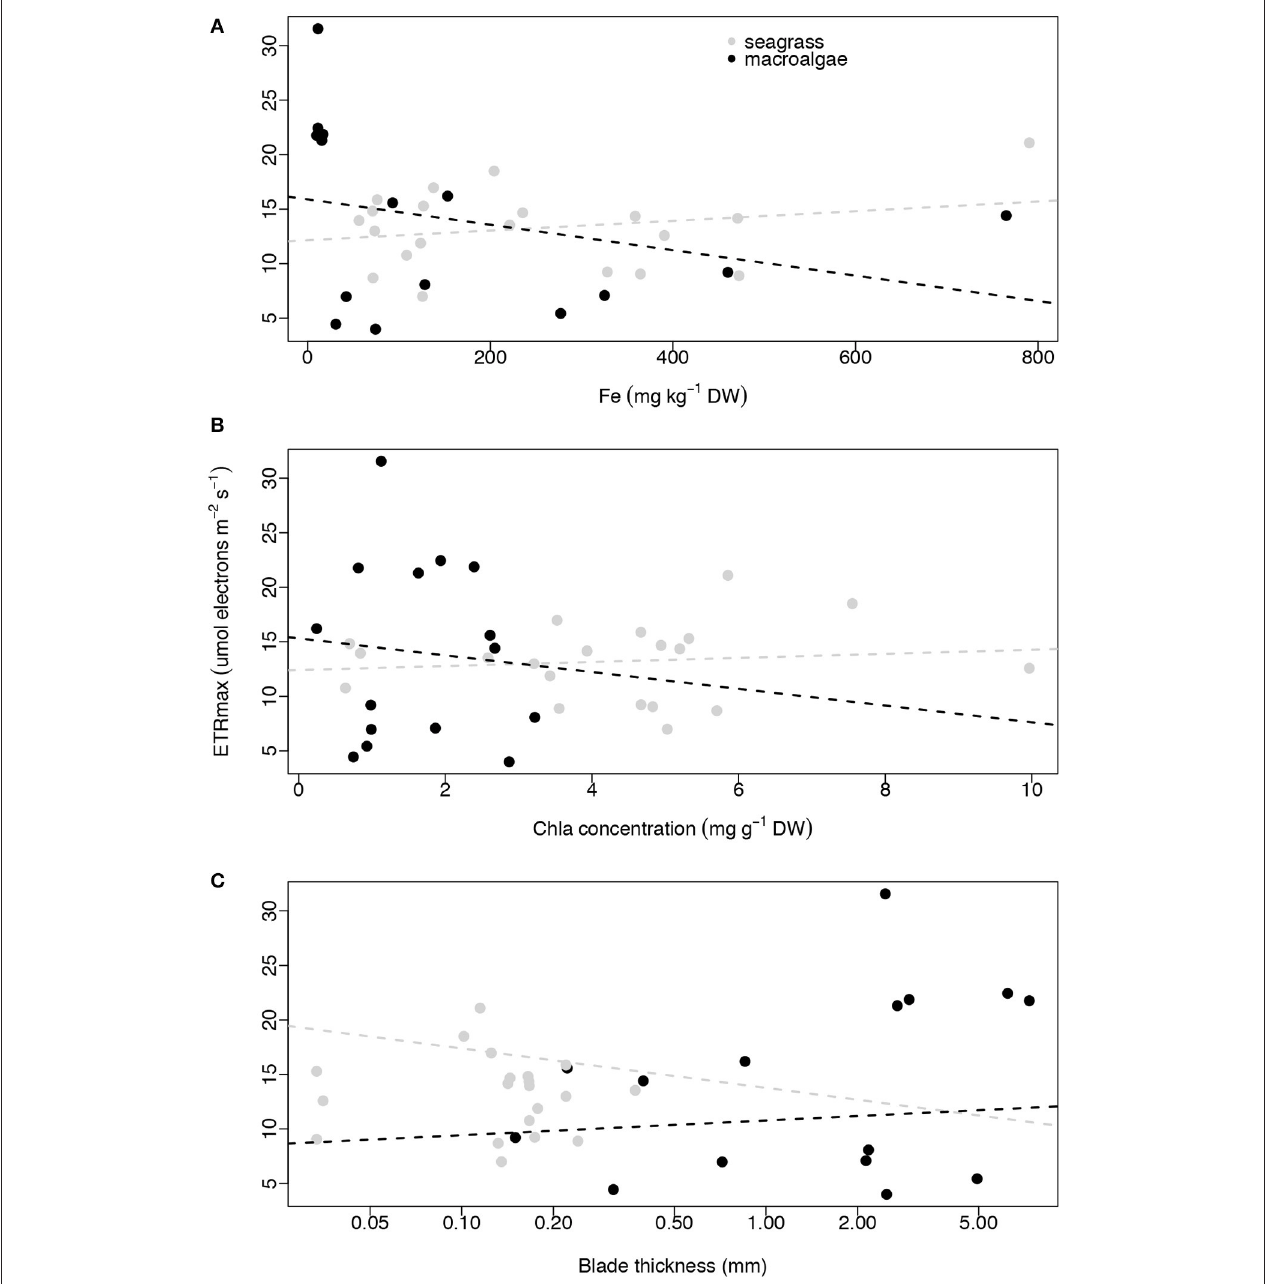
FIGURE 4 | Relationships between average ETRmax ( µ mol electrons m − 2 s − 1 ) and average iron concentration (mg kg − 1 DW; A ), average Chl a concentration (mg g − 1 DW; B ) and average blade thickness (mm; C ) per species per site. Seagrasses are depicted with gray dots and macroalgae with black dots. Non-significant regressions are indicated with a dash line. The number of replicates is indicated in Table 2